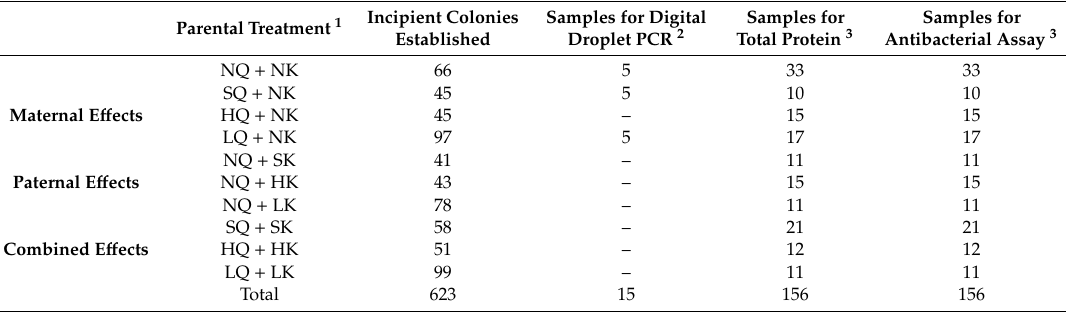
Table 1. Sample sizes by parental